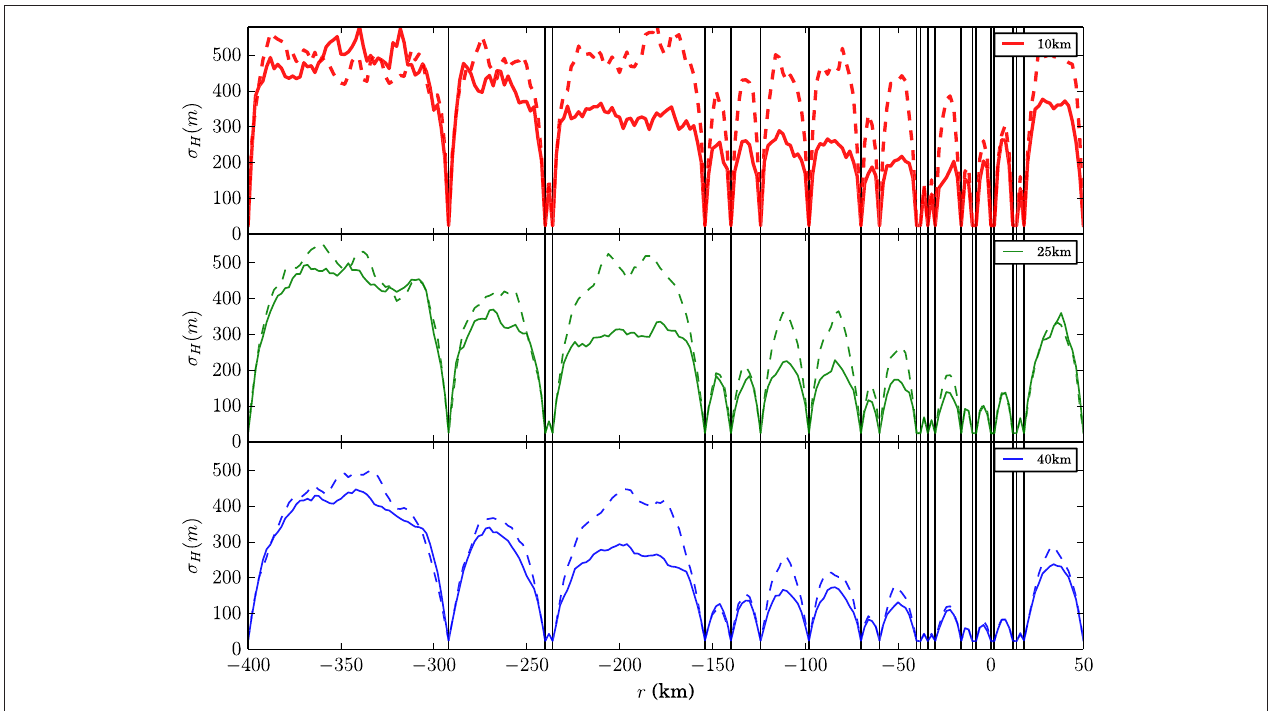
FIGURE 7 | Posterior standard deviations of Jakobshavn Isbræ flowband under different assumptions about the correlation length. Flightline locations are denoted by a vertical black